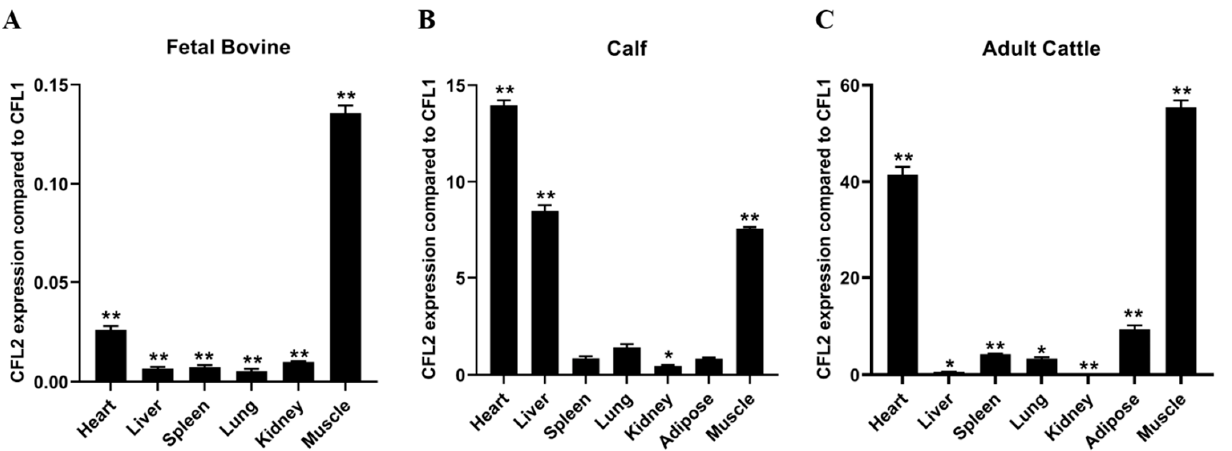
Figure 1. Spatial expression patterns of the CFL2 gene compared to the CFL1 gene in Qinchuan cattle. The relative spatial expression level of CFL2 was analyzed by qRT-PCR in different tissues of Qinchuan cattle at three growth and development stages: fetal bovine ( A ), calf ( B ), adult cattle ( C ). The expression level of the CFL1 gene was considered as 1. The mRNA expression level of CFL1 and CFL2 were normalized to GAPDH. Data are means ± SE of n = 3 independent experiments, each performed in triplicate. *, p < 0.05 and **, p < 0.01.